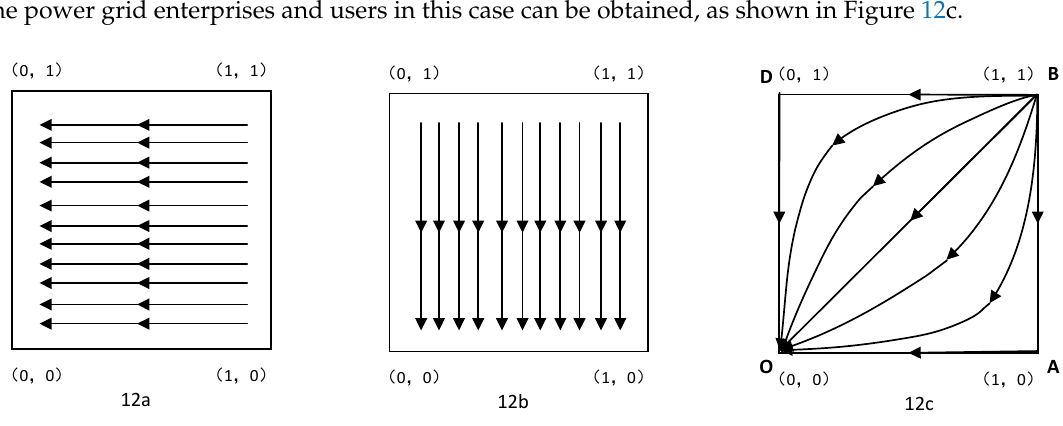
Figure 14. Evolution of the integrated strategy in Case 4.